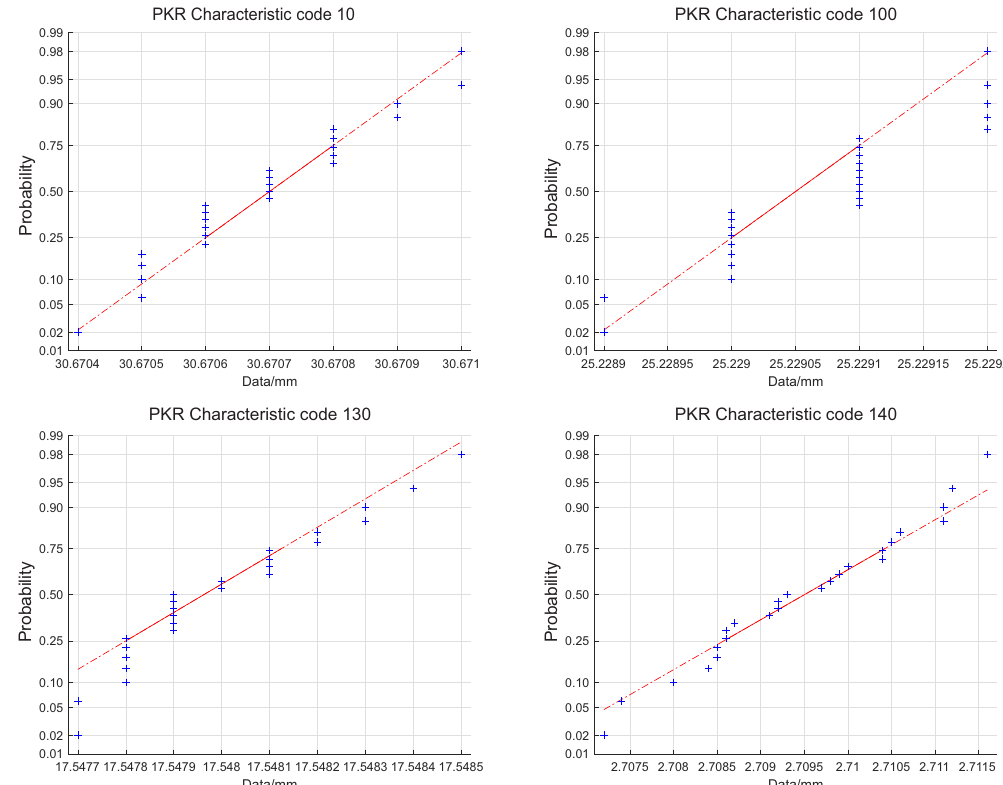
Figure 7. Normal probability plot for measurement codes 10, 100, 130, and 140 of PKR object for measurements of one repetition for measurement scenario 1 (n = 25). Calculated p-values using Anderson Darling normality test are, respectively, 0.743, 0.226, 0.588, and